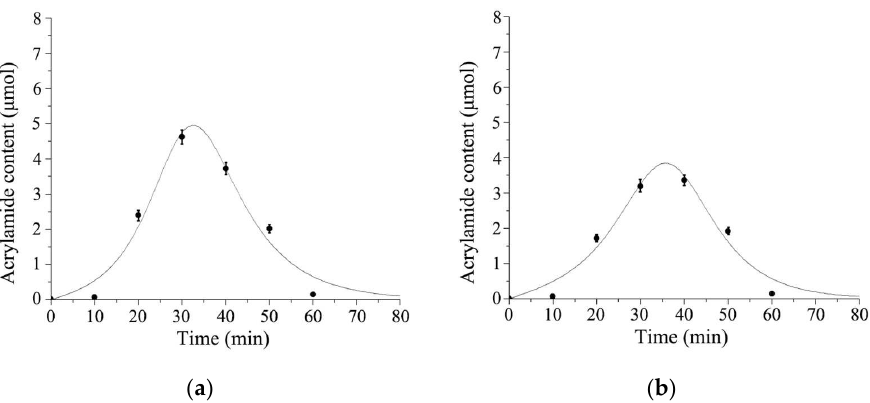
( c ) Figure 5. Reducing effect of allicin on acrylamide content of Glc/Asn solution system. ( a ) Effect of reconstitution solvents of allicin on acrylamide inhibition rate; ( b ) Effect of allicin concentration on acrylamide inhibition rate; ( c ) Effect of allicin addition volumes on acrylamide inhibition rate. As shown in Figure 5b, the inhibition rate of AA gradually increased as the concen-